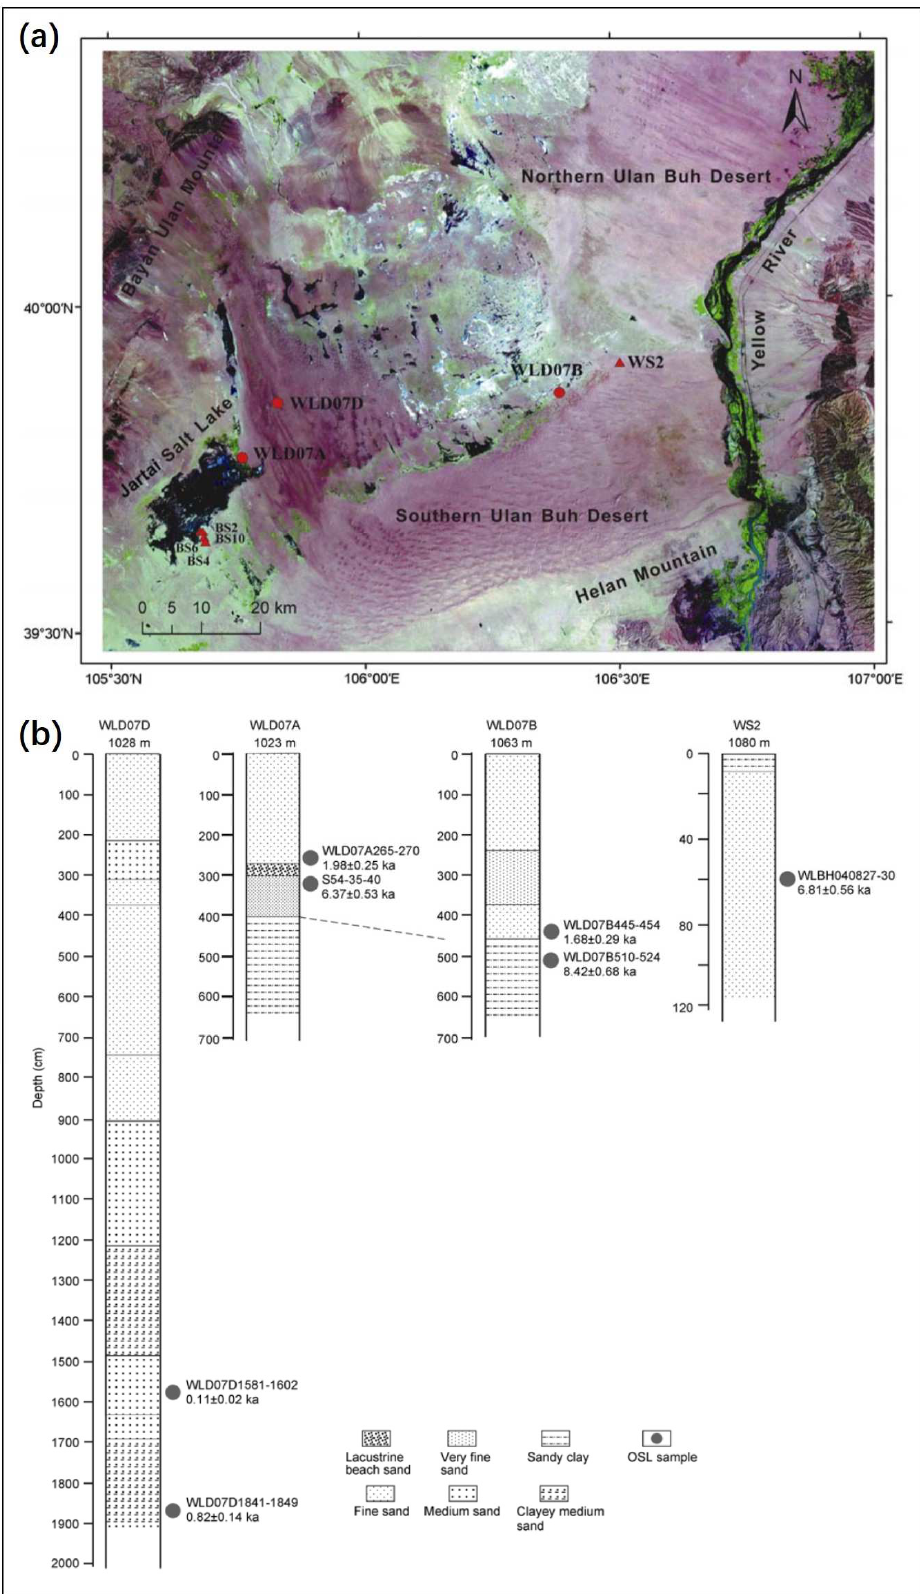
Figure 3. Remote sensing image ( a ) of the Wulanbuhe (Ulan Buh) Desert and the sedimentary cores studied ( b ) (modified from [15,45]). The filled circles in the upper figure are sites of cores in the northern Wulanbuhe Desert reported in [15]; filled triangles are sites of the profiles reported in [45].